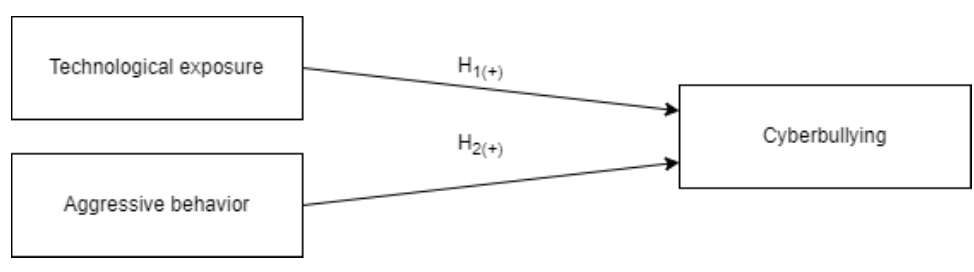
Figure 1. Proposed research model.